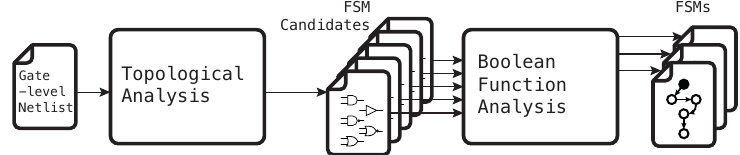
Figure 2: Overview of our FSM reverse engineering work flow. Starting with a third-party, gate-level netlist, we first determine the gates of each FSM candidate using the topological analysis. Afterwards each candidate is processes by the Boolean function analysis to determine the state transition